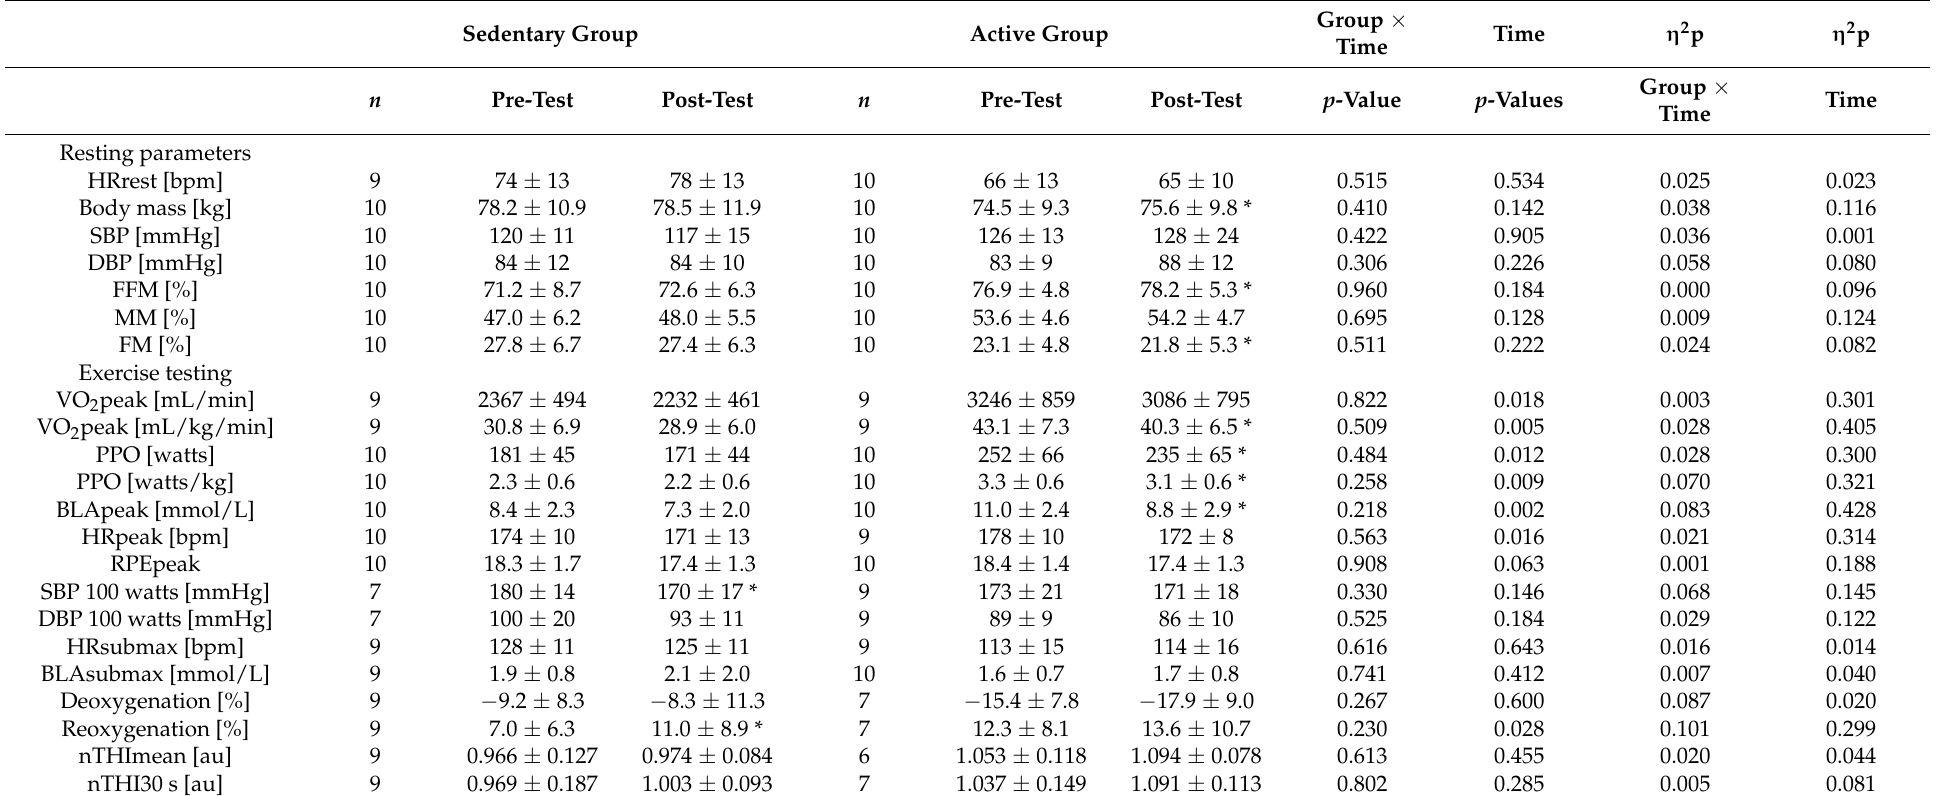
Table 2. Resting and exercising parameters from pre-to post-training. Values are means ±